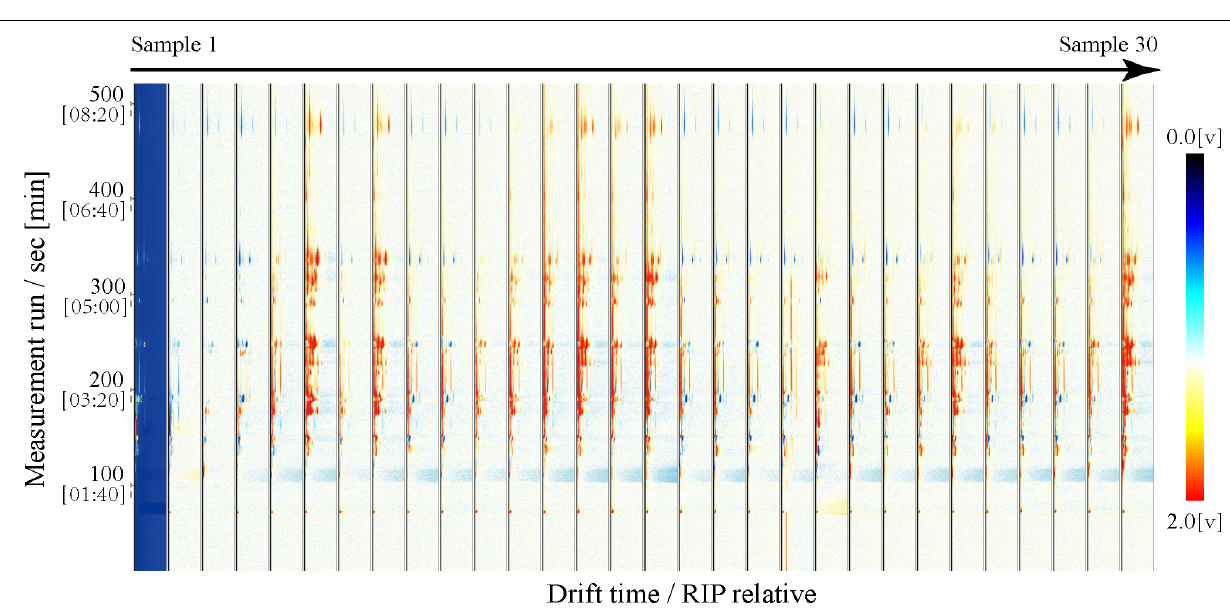
FIGURE 2 | GC-IMS 2D map of Dongxiang tribute